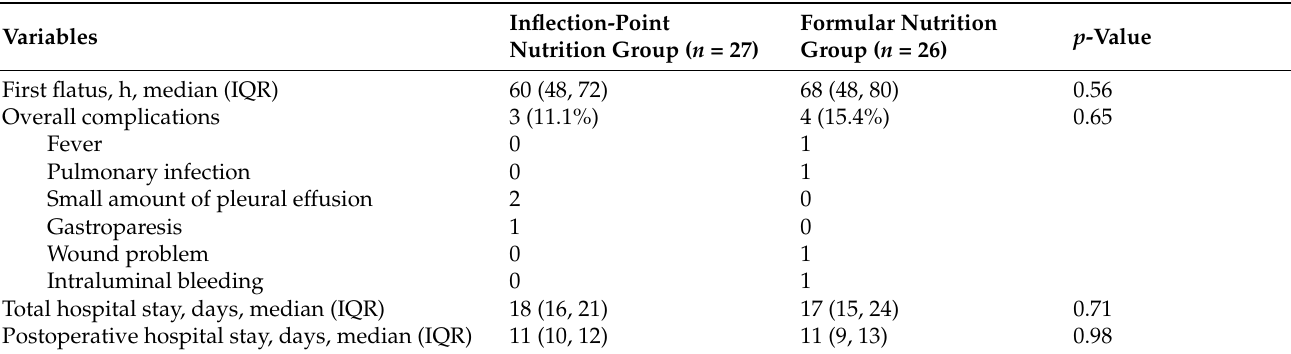
Table 4. Postoperative recovery of patients received inflection-point nutrition (IPN) and formular nutrition (FN) ( n =